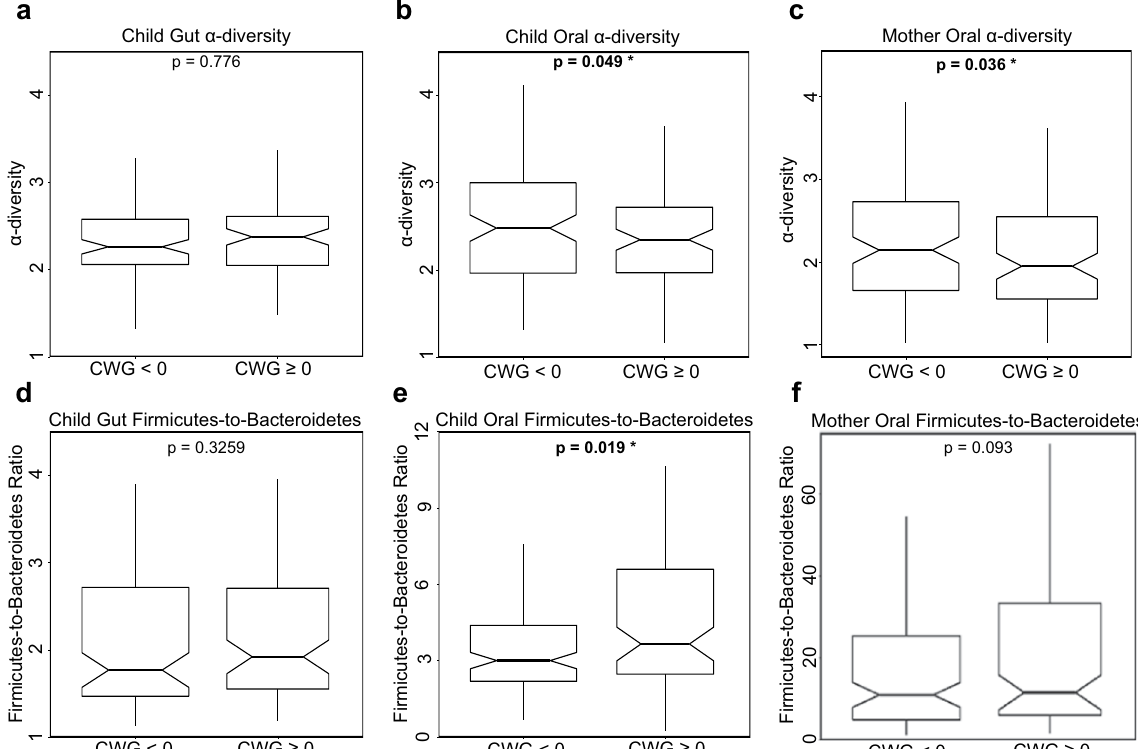
Figure 3. Oral and Gut microbiota’s relationships with conditional weight gain. Notched box-plots contrasting α -diversity and Firmicutes-to-Bacteroidetes (F:B) ratio in two-year-old children with rapid (CWG ≥ 0) vs. non-rapid (CWG < 0) weight gain, and in their mothers. ( a,d ) for the gut microbiota in children with rapid (N = 90) vs. non- rapid (N = 99) weight gain; ( b,e ) for the oral microbiota in children with rapid (N = 97) vs. non-rapid infant weight gain (N = 117); ( c,f ) for the oral microbiota in mothers of children with rapid infant weight gain (N = 102) vs. mothers of children without rapid infant weight gain (N = 113). All p-values were obtained using one-tailed Mann-Whitney U tests, significant p-values are shown in bold. Outliers were not plotted but were included in the statistical tests.